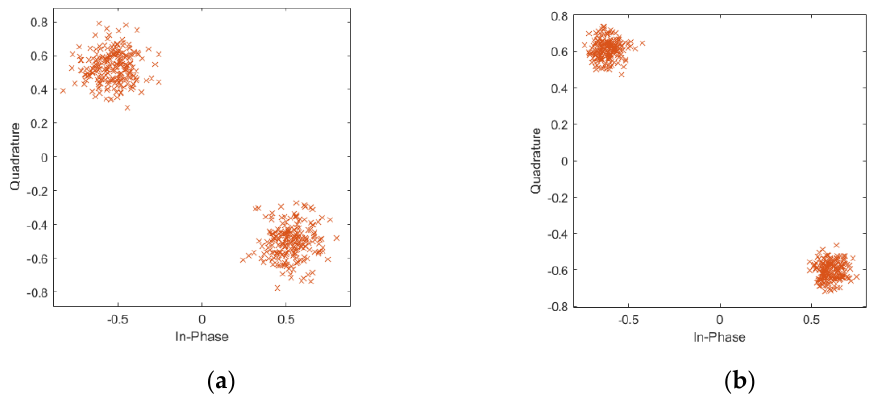
Figure 4. Symbol constellation diagram of measured DTMB signal without phase rotation: ( a ) before noise reduction; ( b ) after noise reduction.